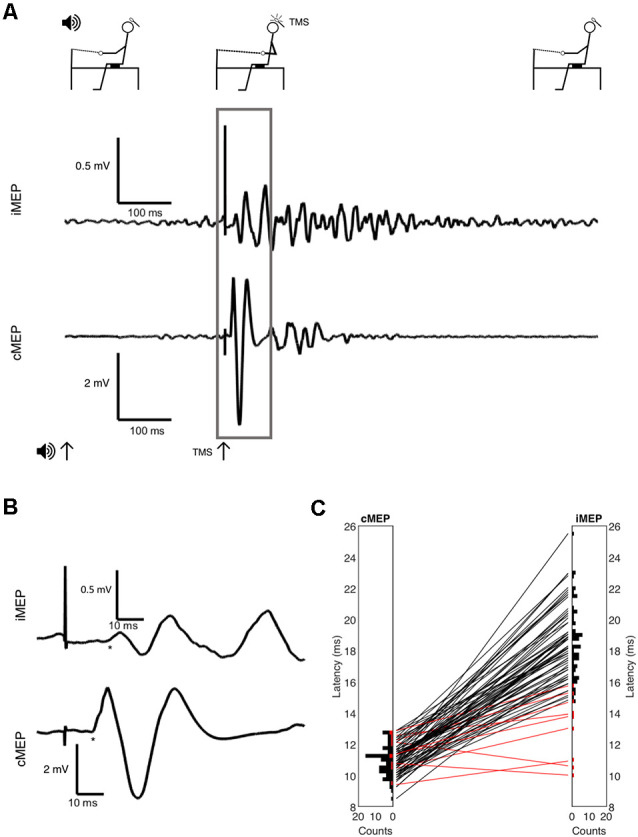
(A) Full experimental paradigm showing subject position, the onset of auditory cue at t = 0, the onset of Transcranial Magnetic Stimulation (TMS) at t = 300 ms, and EMG. Volitional EMG activity builds after auditory cue, with large synchronous motor evoked potential (MEP) after TMS indicated and inset in panel (B) with selected area and onsets marked with * symbol. (C) Latency histograms and differences between contralateral MEP (cMEP) and ipsilateral MEP (iMEP) latencies shown. Each line is a subject, with iMEPs deemed invalid due to low latency difference (<5 ms) in red.